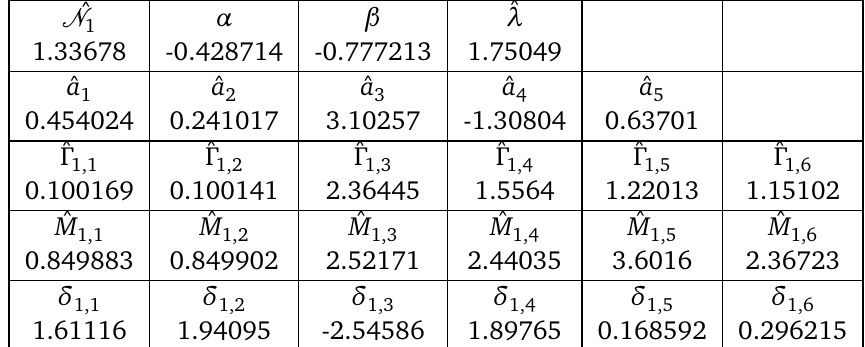
Table 1: Parameters obtained in our best fit for the ansatz